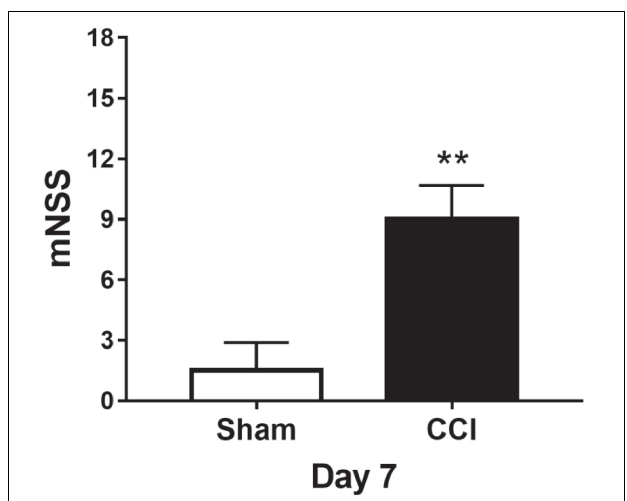
FIGURE 2 | The assessment of neurological deficits on day 7. ** p < 0.01 vs. sham.